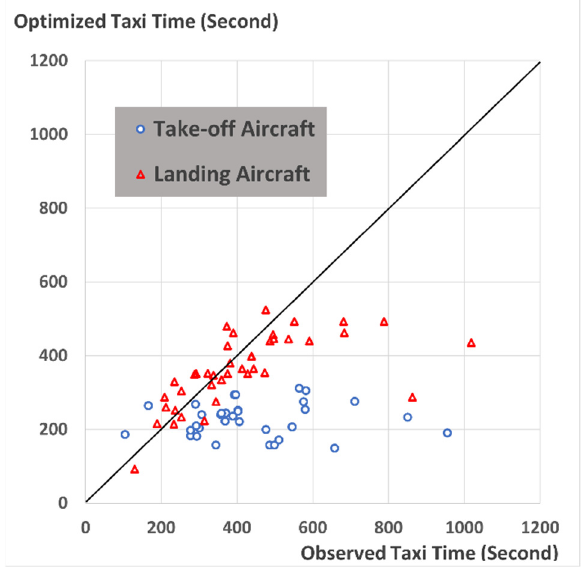
Figure 12. Result comparison of total taxi time with runway reselection. Table 3. Decreasing rate of total taxi time.